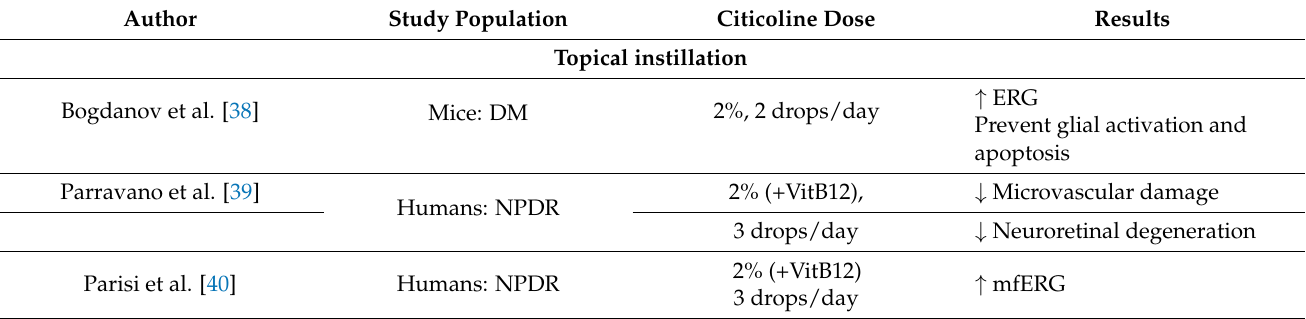
Table 2. Summary of articles that relate citicoline to DR, classified according to administration